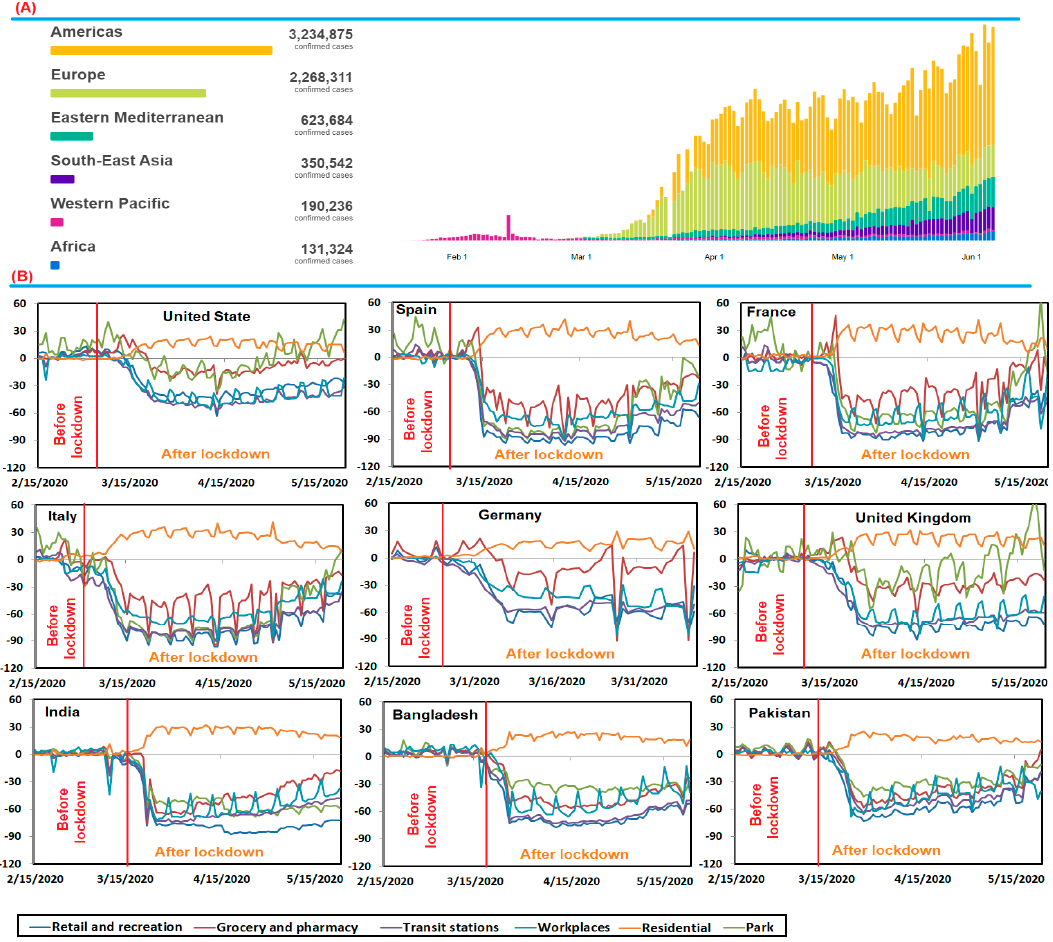
Figure 2. Mobility index of different human activities before and after the lockdown being put into effect. ( A ) The daily data of cases confirmed with COVID-19 in different regions of the world. ( B ) The mobility index changes of different human activities with time in different cities.